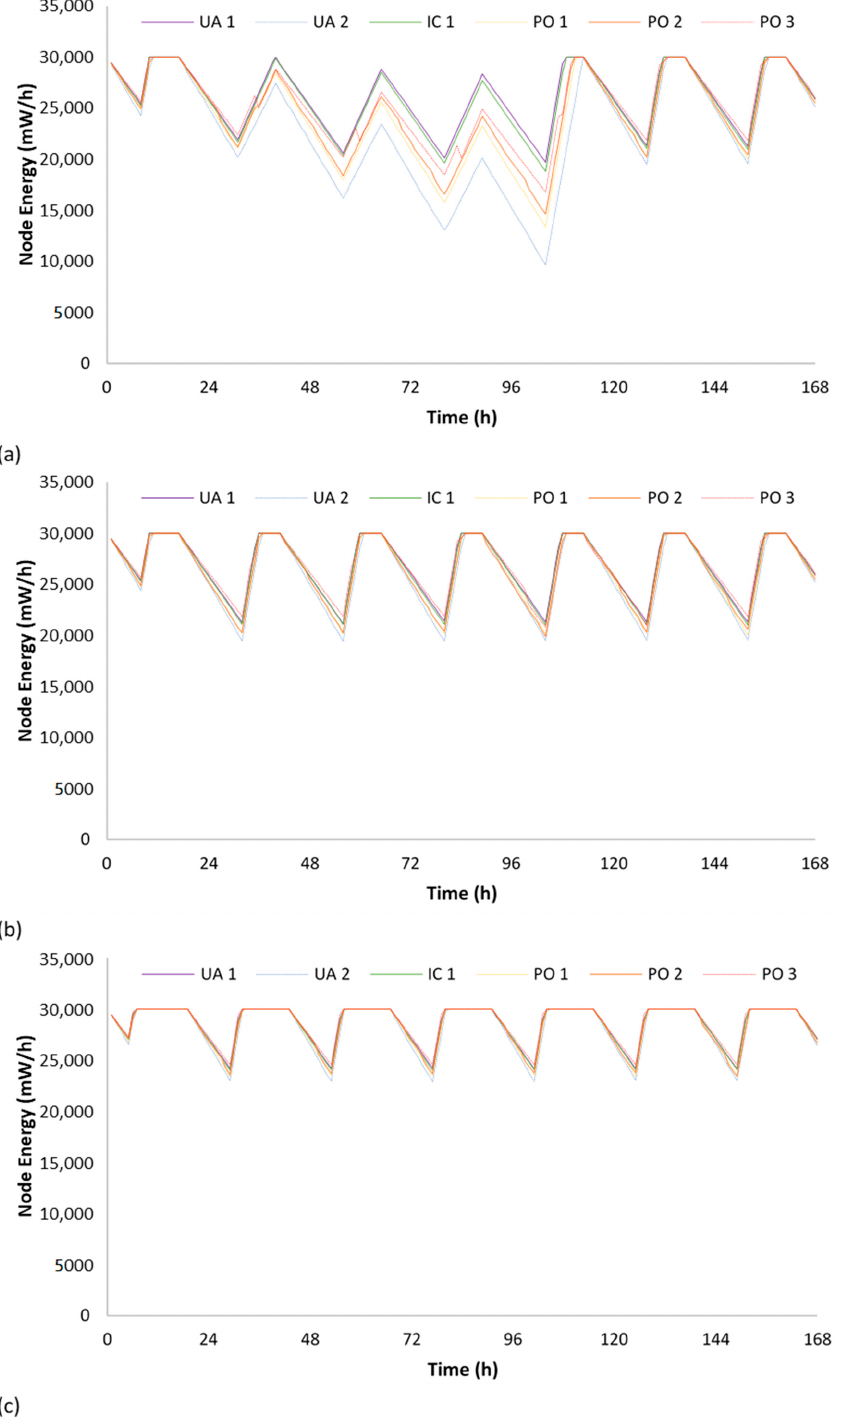
Figure 13. Energy consumed by the nodes. Summary of the whole simulated period. Different letters (a– f ) denote different ambient conditions: ( a ) winter period with reduced energy harvesting for three days, ( b ) winter period with full energy harvesting, ( c ) summer